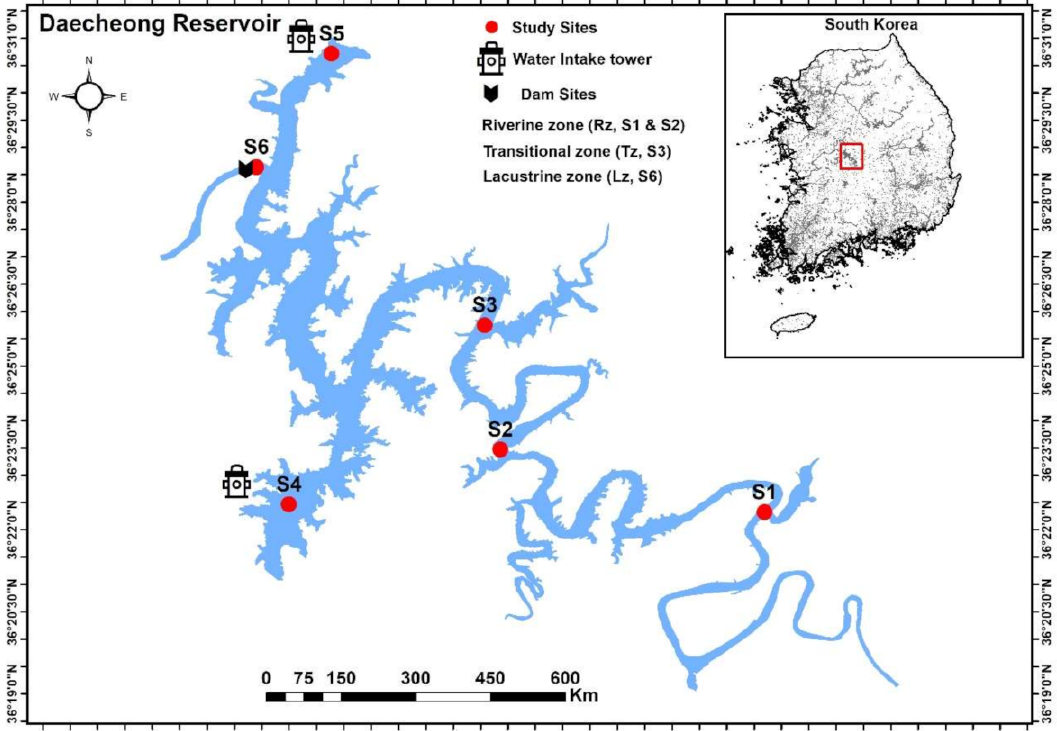
Figure 1. Study area map showing the sampling sites of the Daecheong Reservoir. S1 and S2: riverine zone (Rz); S3: transitional zone (Tz); S6: Lacustrine zone (Lz); S4 (IT1) and S5 (IT2): intake tower of drinking